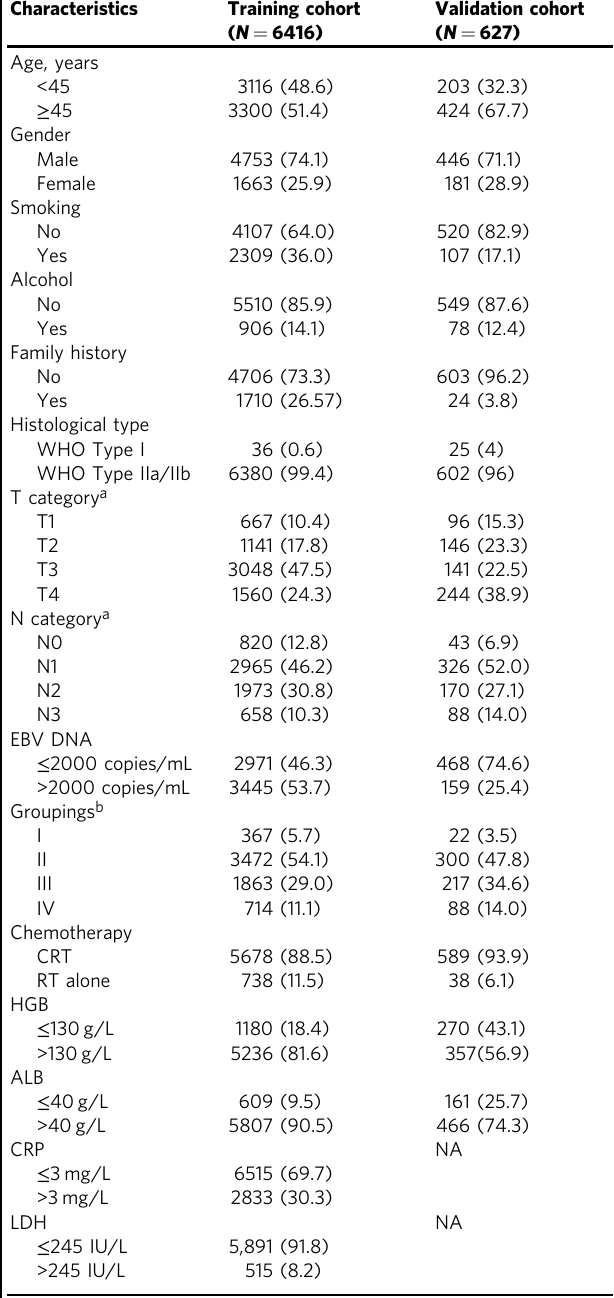
Table 1 Demographic and baseline characteristics of patients in the training and validation